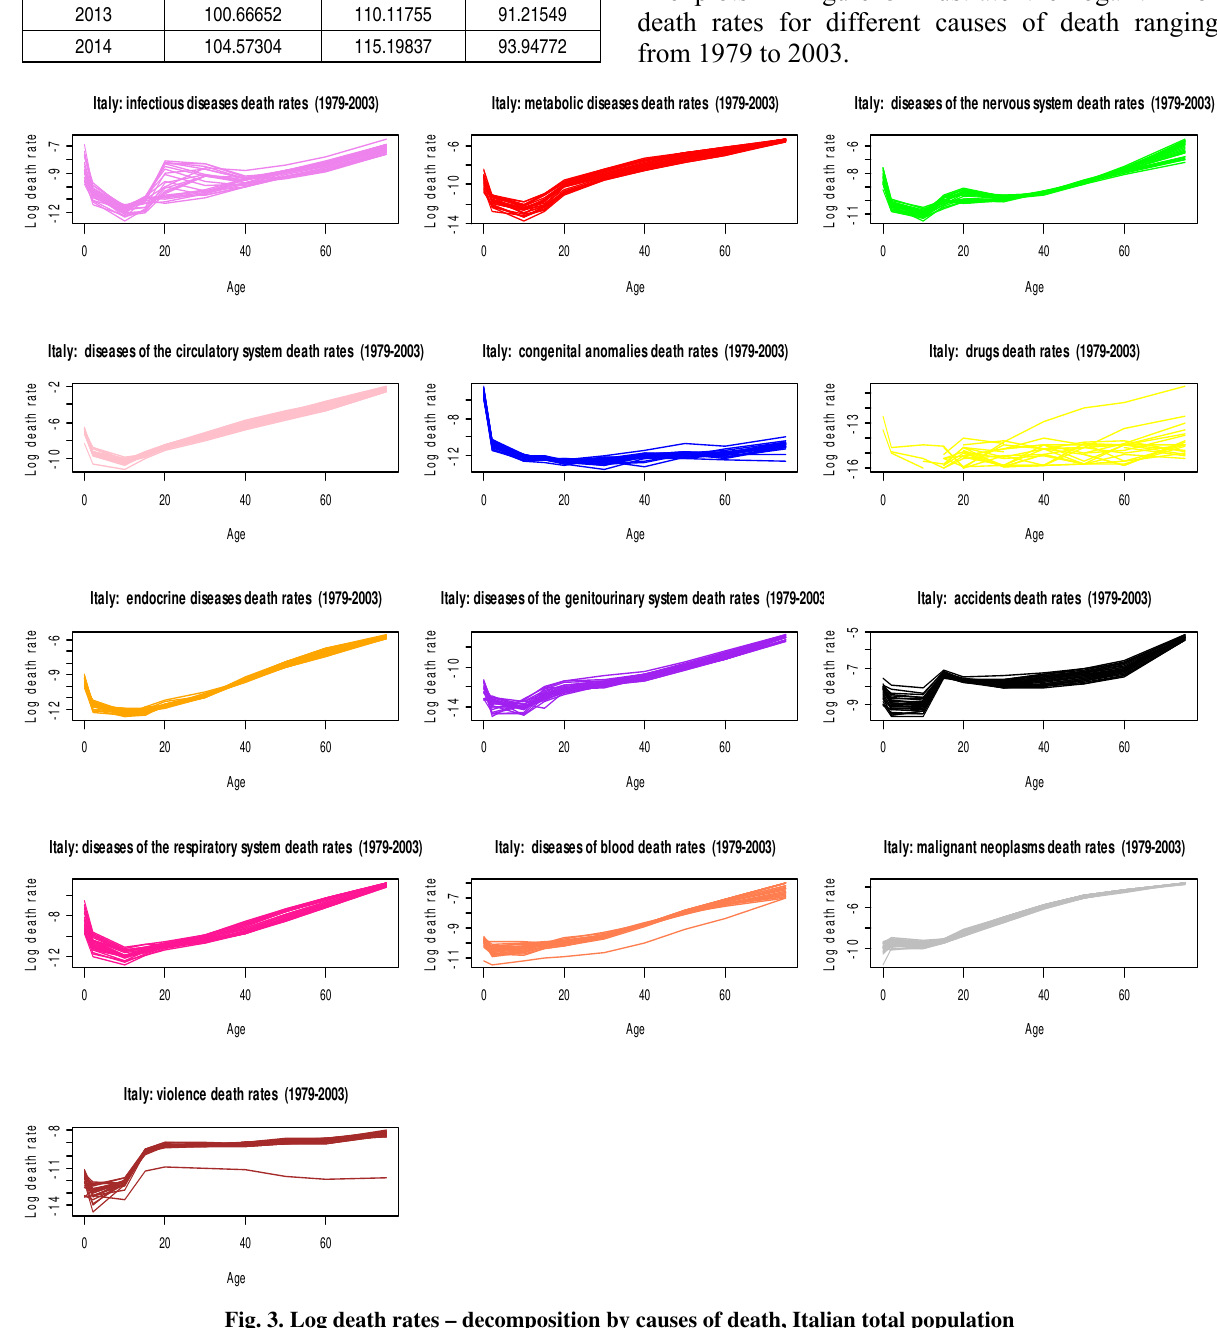
Fig. 3. Log death rates – decomposition by causes of death, Italian total